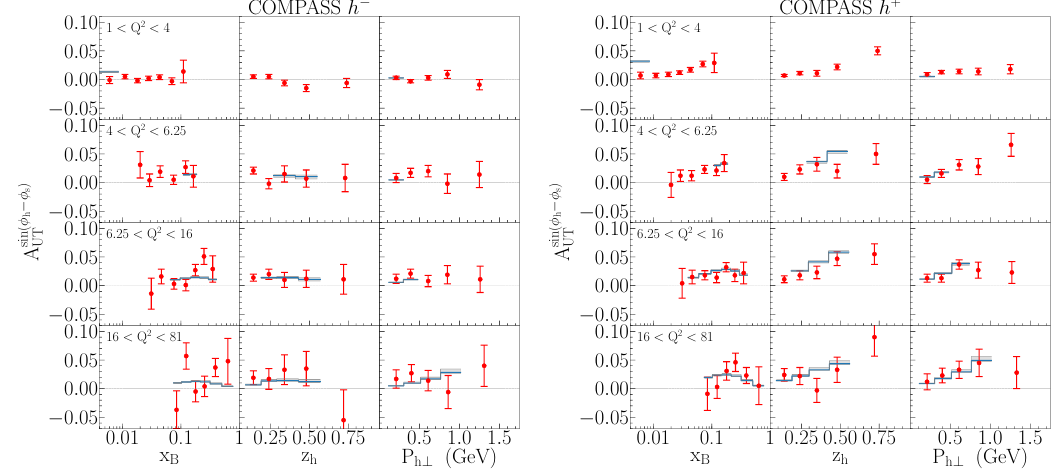
Figure 9 . Left: the COMPASS proton target measurement for h − for 1 GeV 2 < Q 2 < 4 GeV 2 , 4 GeV 2 < Q 2 < 6 . 25 GeV 2 , 6 . 25 GeV 2 < Q 2 < 16 GeV 2 , 16 GeV 2 < Q 2 < 81 GeV 2 from top to bottom [43]. Right: same as the left except for h + production. The central curve as well as the uncertainty band are generated using the result from fit 1 in table